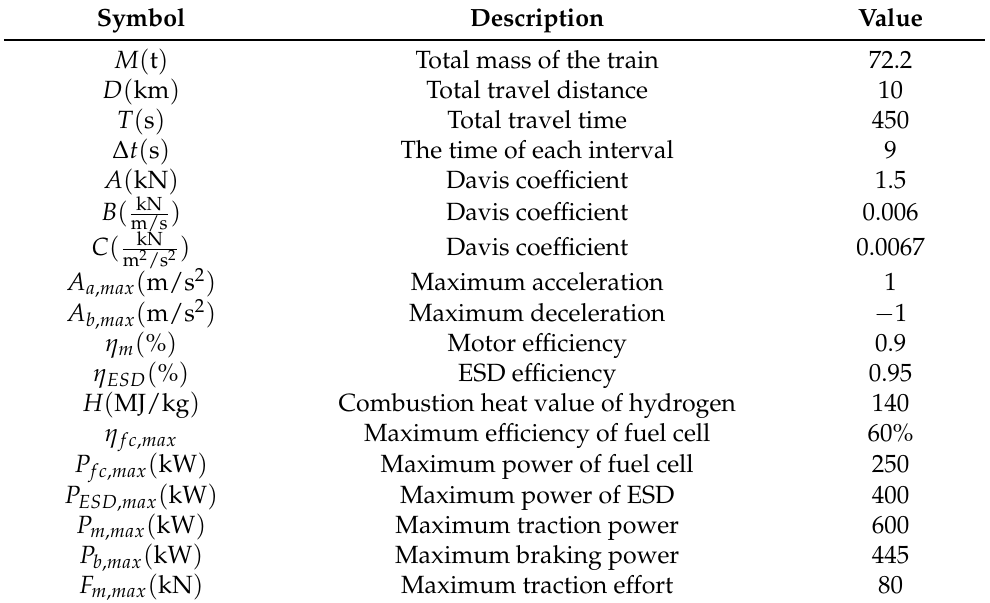
Table 3. Key parameters used in the FCHT model.